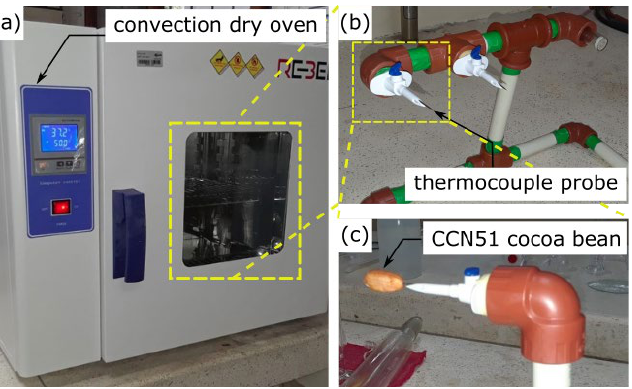
Figure 2. The experimental setup for the drying process of a cocoa CCN51 bean. ( a ) Convection dry oven; ( b ) sample holder; ( c ) bean inserted into a detachable cannula. The ambient temperature and humidity were 26 °C and 72%, respectively. The air temperature inside the drying chamber was 50 °C. The detrimental temperature to cocoa quality is approximately 60 °C [35]. Dehydration at higher temperatures produces exces- sive acid entrapment inside the beans, which causes flavor loss.